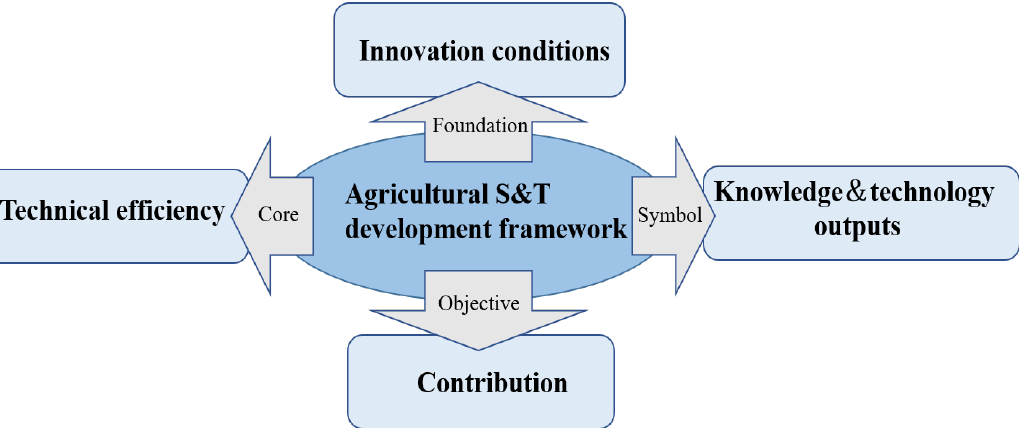
Figure 1. Framework for agricultural science and technology development